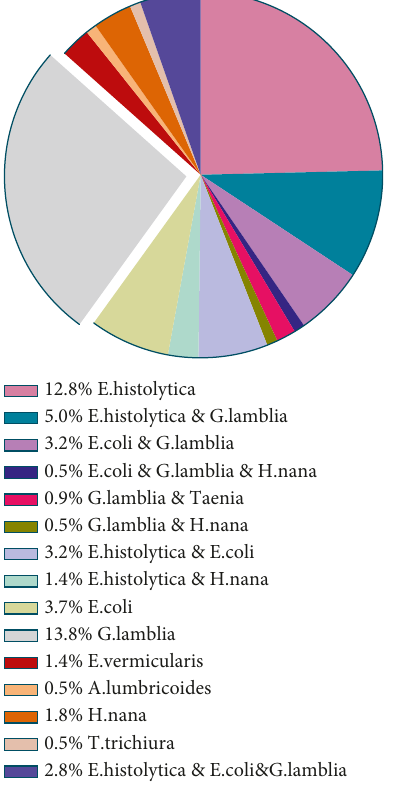
Figure 3: Comparison of the prevalence (%) of intestinal parasitic species among participants.